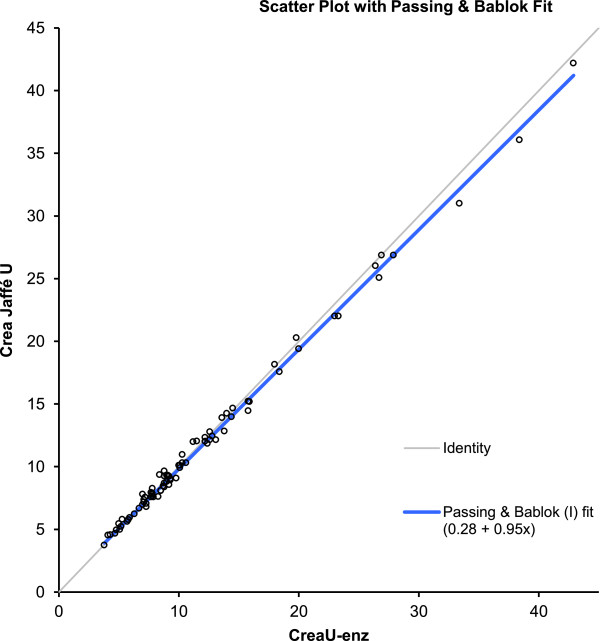
Passing-Beblok (y = 0.28 + 0.95 ×, 95% CI slope 0.93-0.98, 95% CI intercept 0.12-0.48) between enzymatic and Jaffe creatinine measurements (both mg/dL). (X-axis = creatinine in urine enzymatic, CreaU-enz, mg/dL; Y-axis = creatinine in urine Jaffe, Crea Jaffe U, mg/dL).